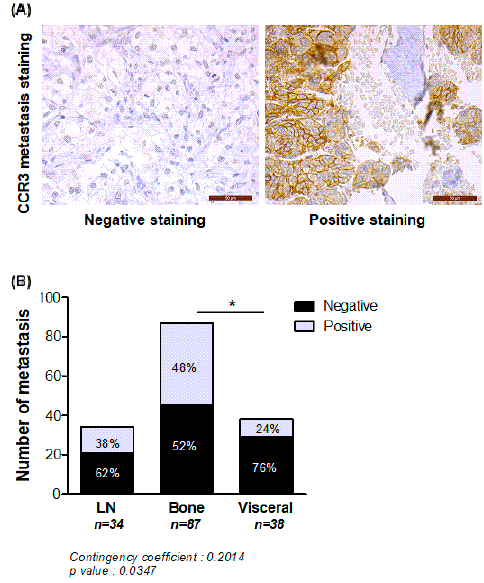
Figure 5. CCR3 is overexpressed in bone compared to visceral metastasis in human PCa. Metastatic PCa samples coming from different sites ( lymph nodes (LN), visceral or bone) were stained for CCR3, and categorized as positive or negative for CCR3 expression. ( A ) Representative examples of negative and positive staining in bone metastases are shown. Scale bars, 50 μ m. ( B ) Quantification of the number of metastasis negative or positive for CCR3 according to their anatomical location (LN ( n = 34), visceral ( n = 38) or bone ( n = 87). Percentage of each group is mentioned in each bar graph. Chi2 statistic test was performed ( p = 0.0347) and contingency coefficient was calculated (0.2014). Comparison between location was evaluated by fisher’s exact post-test (* p <